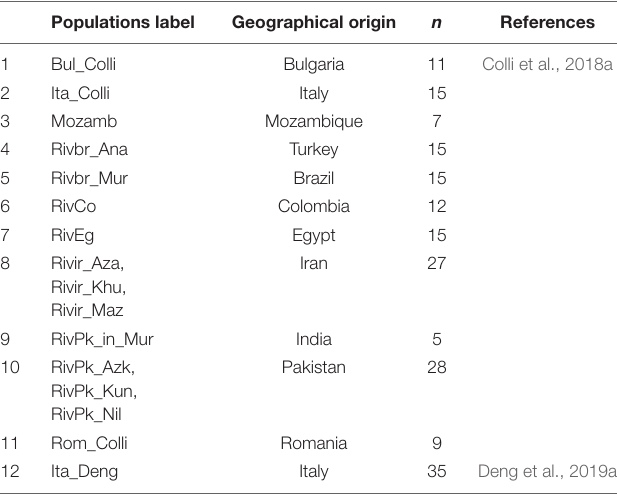
TABLE 2 | Populations of buffalo with publicly available genotype data included in the present genome analysis (n: samples per population).